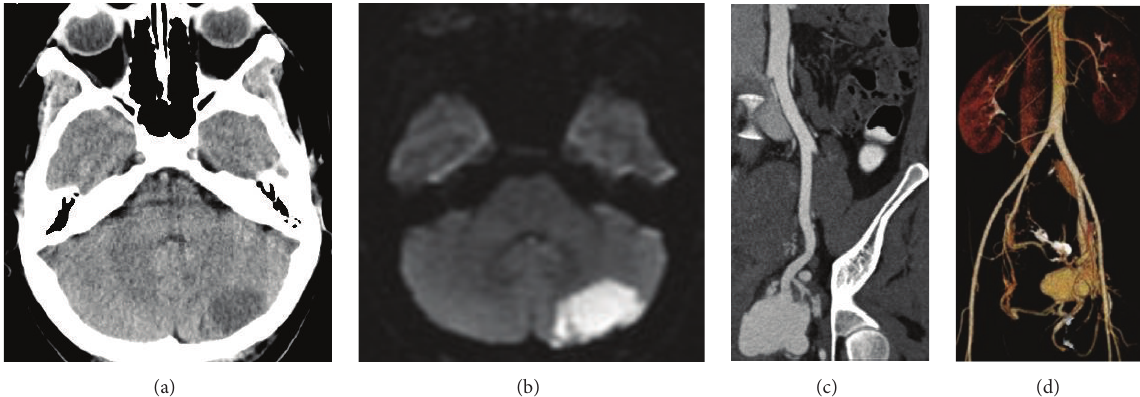
Figure 1: (a) Noninjected head CT with hypodense left hemicerebellar lobe. (b) Brain MRI: diffusion sequence confirming the hyperintense left hemicerebellar ischemic lesion. (c) Coronal oblique view of the pelvic mass in the arterial phase. (d) Volume rendering showing the mass with its arterial supply and venous drainage. Iliac vein thrombosis is not shown in this